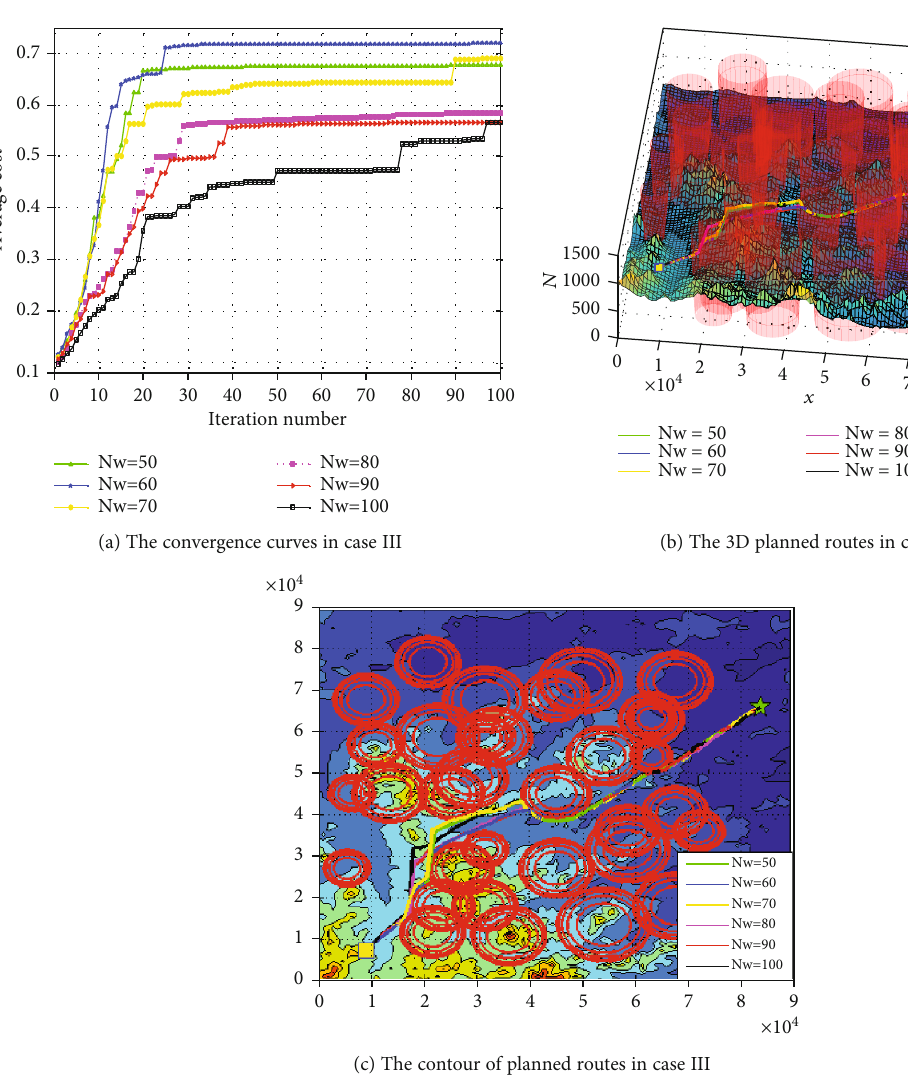
Figure 8: The comparison of results with di ff erent numbers in case III. Table 2: The parameter values of di ff erent